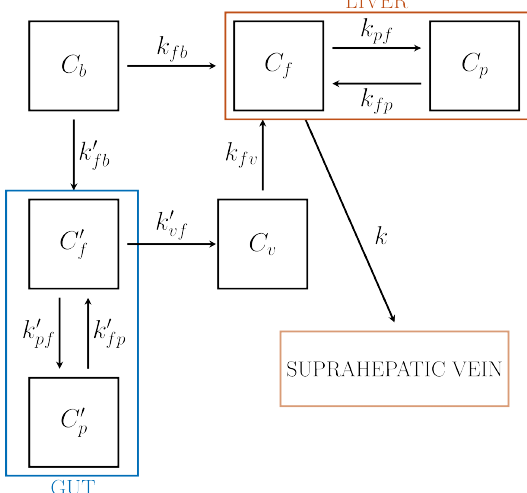
Figure 6. Compartment model for